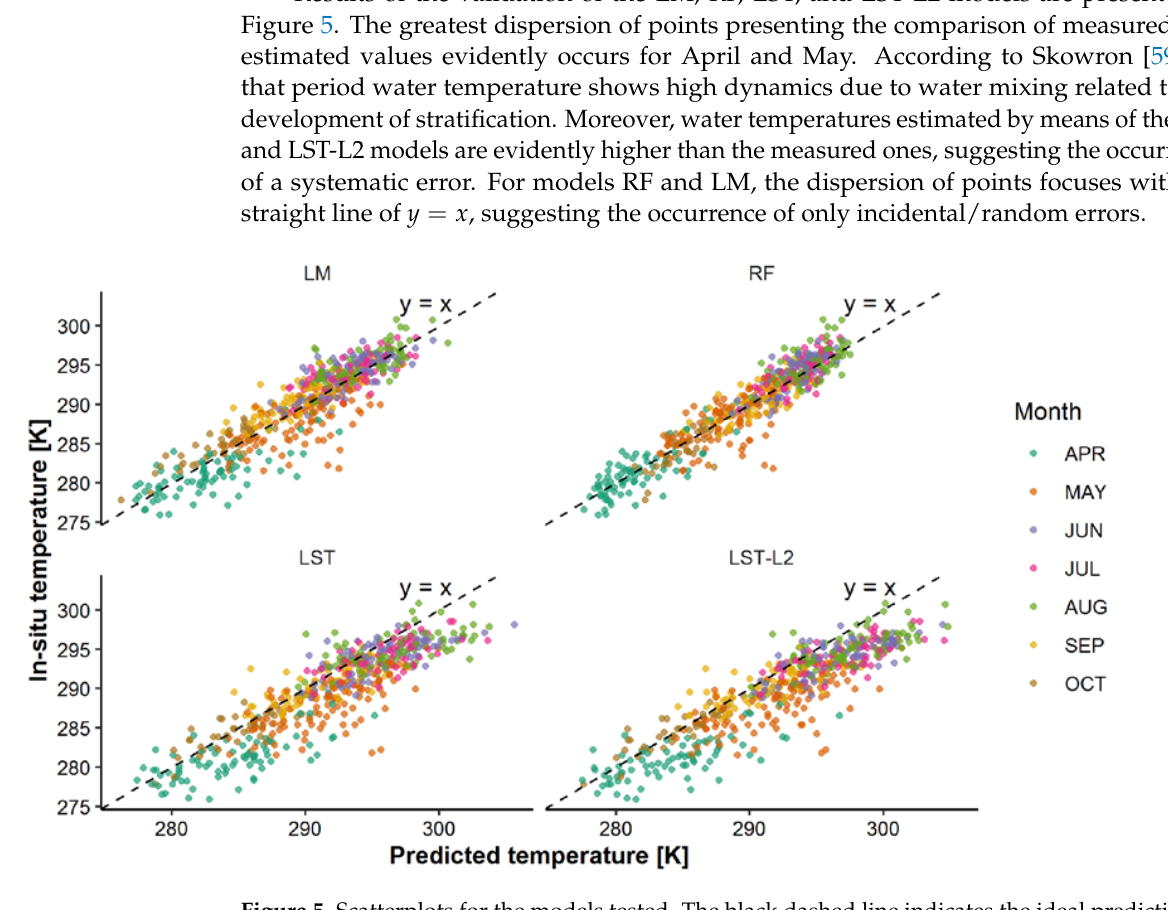
Figure 5. Scatterplots for the models tested. The black dashed line indicates the ideal prediction. A systematic error can be noticed for the LST and LST-L2 models.